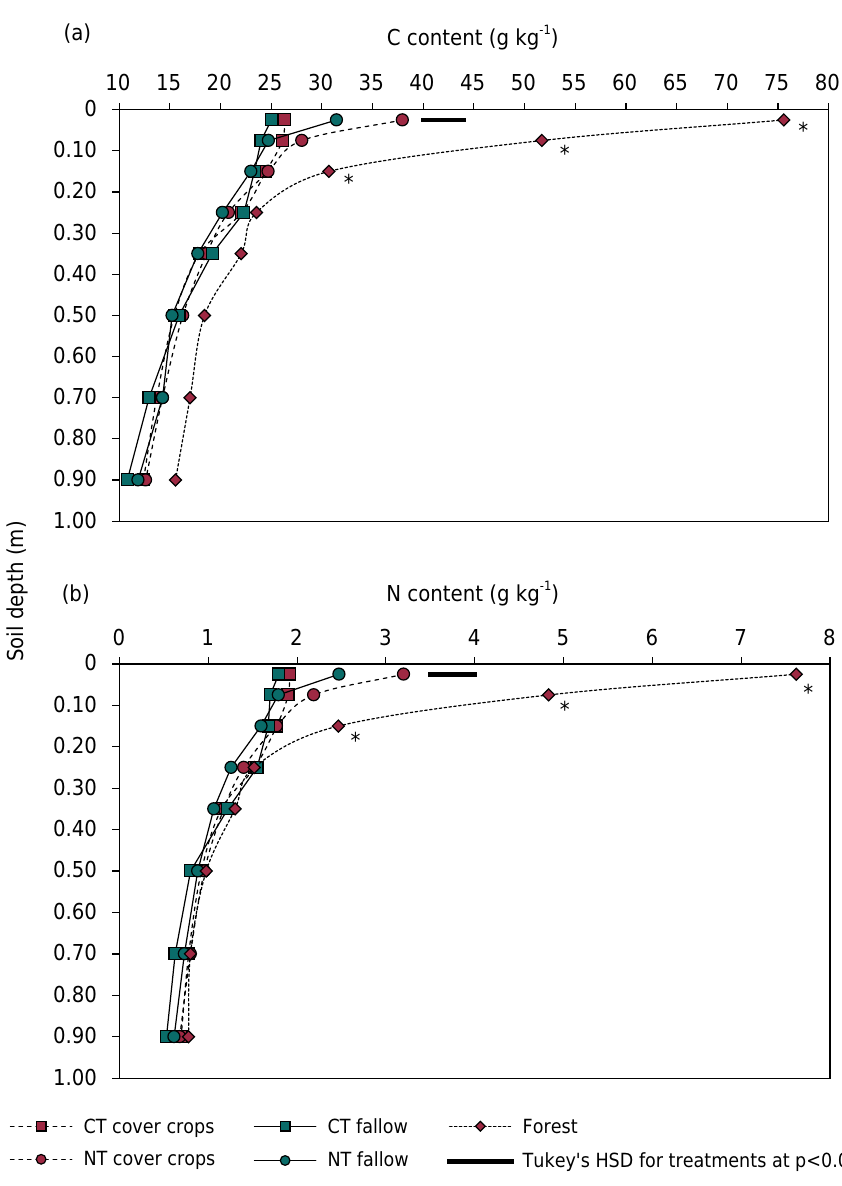
Figure 2. Carbon (a) and nitrogen (b) content in the 0.00-1.00 m soil layer as affected by soil tillage (CT: conventional tillage; NT: no-tillage) and winter cover crops. Forest soil was not compared statistically with the experimental treatments. Asterisks indicate a significant difference in the C or N content in each soil layer between the forest soil ( n = 3) and the cultivated soil (NT plus CT treatments, n = 48) by the non-parametric Mann-Whitney U